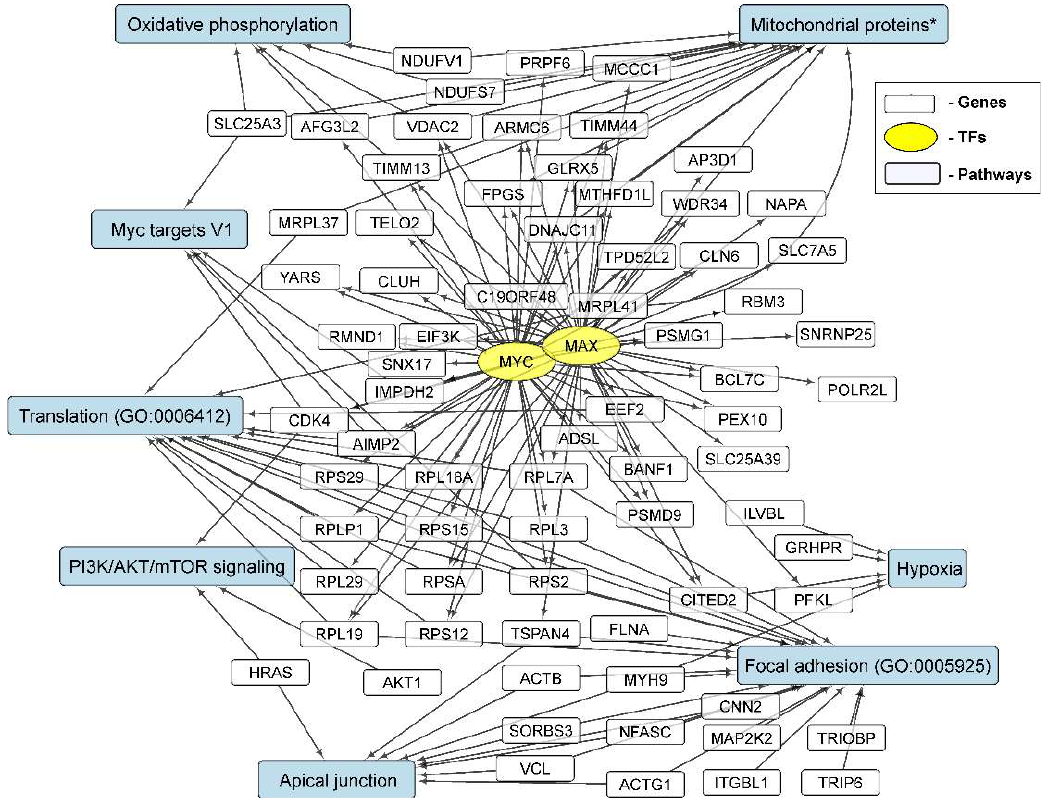
Figure 8. Relationships between MYC and MAX transcription factor repression, particular downregulated genes and signaling pathways, and biological processes common for glioma NS cell cultures formation. Summarized results of gene sets analysis with the Enrichr libraries “GO Biological Process 2021” and “KEGG_2021_Human”, as well as recently published data presented in the text (marked with *).